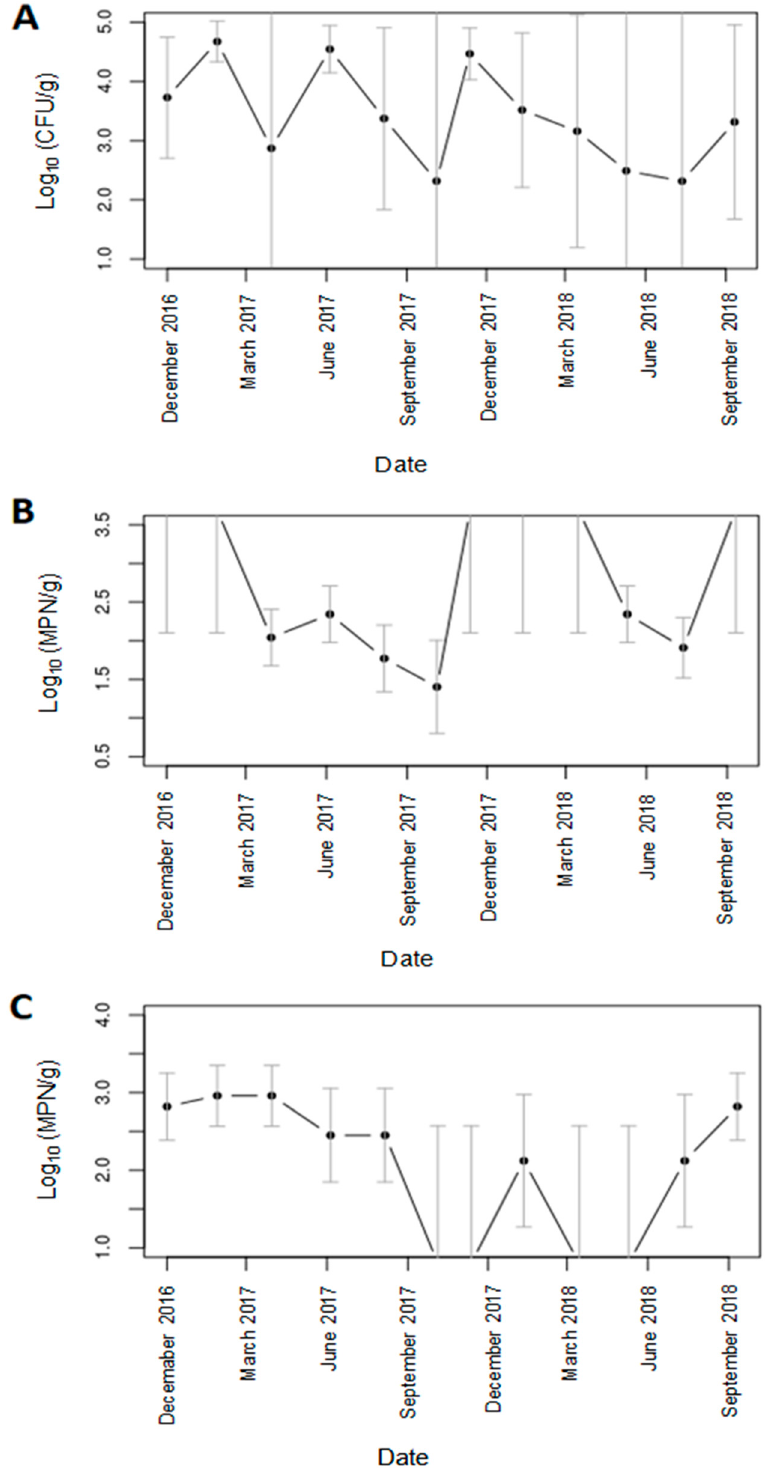
Figure 3. Estimated mean numbers of Xcc in soil obtained by: ( A ) inverse estimation from nested real-time PCR Ct values ( B ) most probable numbers from nested real-time PCR ( C ) most probable numbers from conventional PCR with hrpF primers. Values were obtained as predictions from the appropriate generalized linear model. Error bars represent the 95% confidence intervals. It should be noted that values outside the scale range in ( B ) and ( C ) represent sample dates when all samples were positive ( B ) or al samples were negative ( C ) and therefore it is not possible to obtain estimates, only lower ( B ) or upper ( C ) confidence limits.